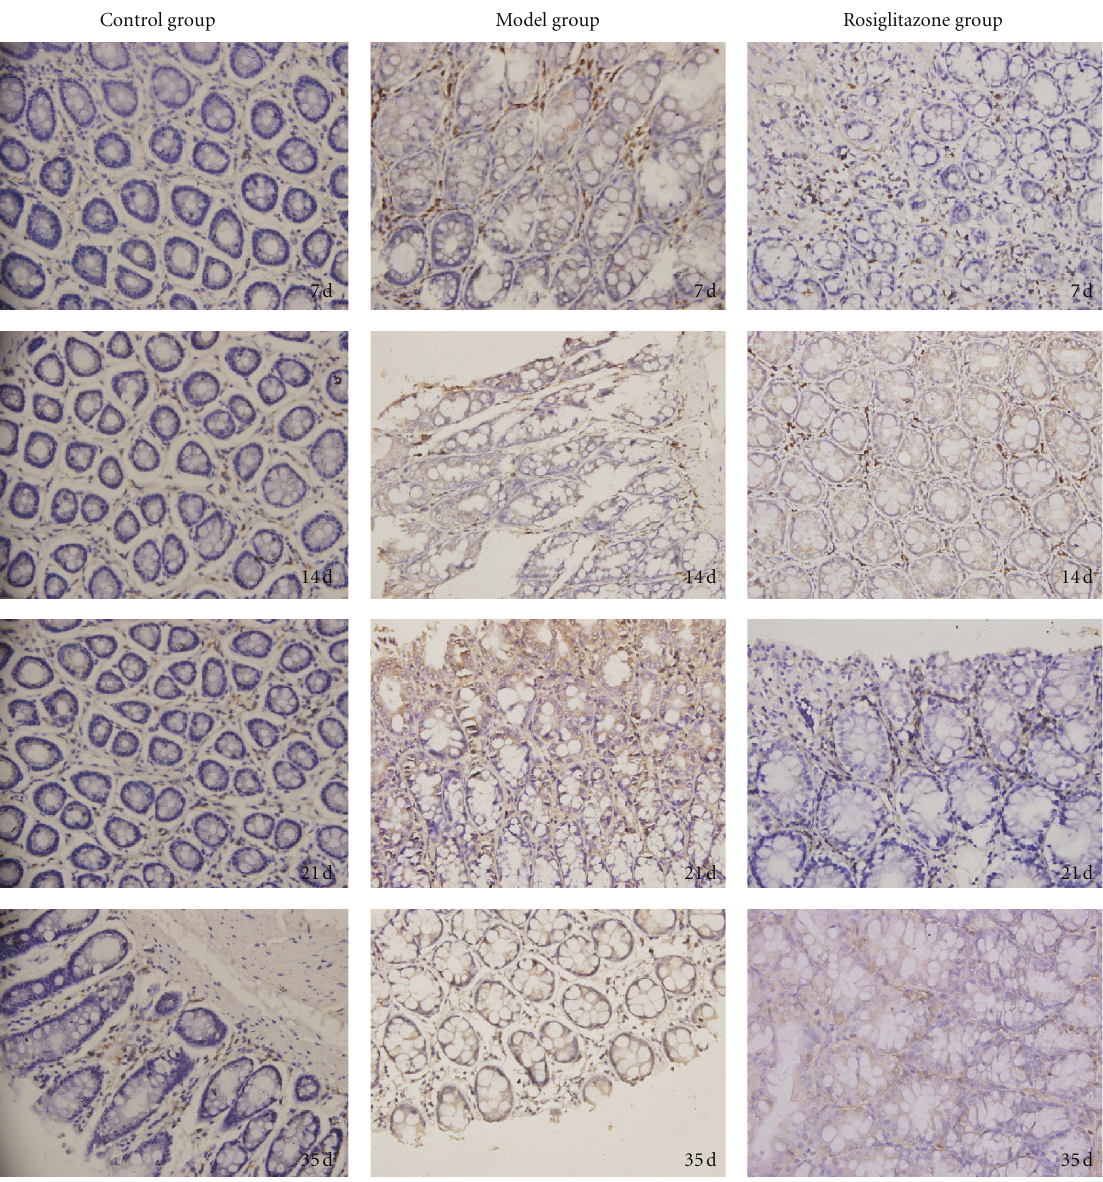
Figure 3: Colonic mucosal NF- κ B protein expression in the control group, UC model group, and rosiglitazone treated group on days 7, 14, 21, 35. In the control group, expression of NF- κ B protein in the colonic mucosa was significantly less compared to the UC model group ( P < 0.05). In the rosiglitazone treatment group, NF- κ B protein expression reduced significantly than that of the model group on days 7, 14, 21, and 35 ( P < 0.05).